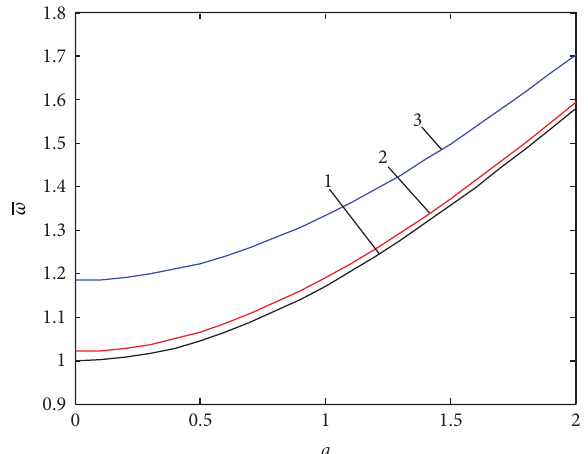
Figure 3: Average resonant frequency for different values of the fast excitation parameter 𝐸 22 ⋅ 𝑟 𝑓 . Line 1: no fast excitation; line 2: 𝐸 22 ⋅𝑟 𝑓 = 0.3; line 3: 𝐸 22 ⋅ 𝑟 𝑓 =